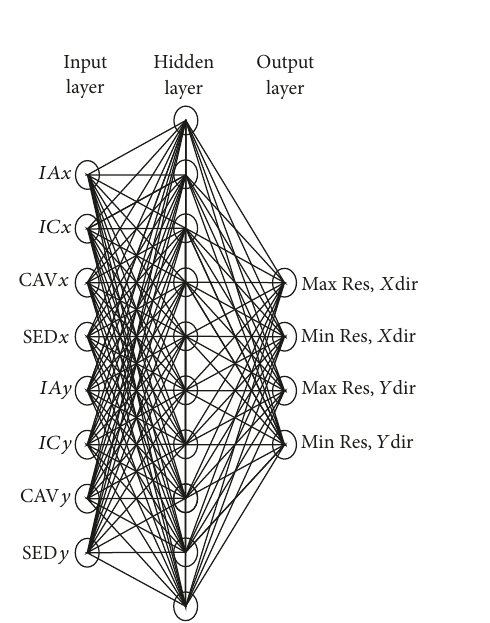
Figure 4: Architecture of ANN model.